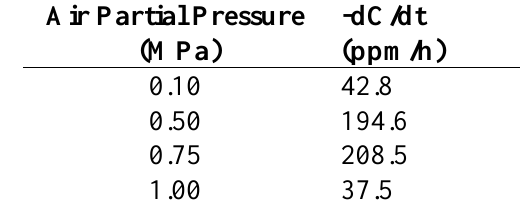
Table 1. Phenol instantaneous consumption rate (-dC/dt) in CO (35 ºC, CO partial pressure = 7.0 MPa ) for different air partial pressure at the first 30 2 minutes of